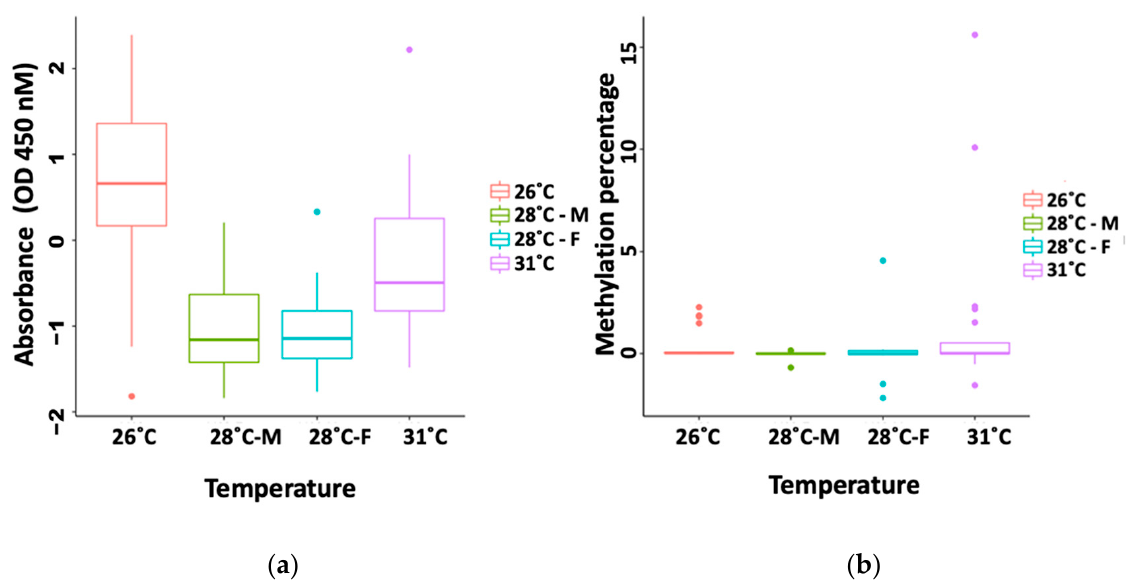
Figure 2. ( a ) Absorbance and ( b ) percent 5-mC DNA methylation values by temperature and sex measured by ELISA in the tail of Chrysemys picta hatchling tail tissue. Table 1. ANOVA results for absorbance and percent 5-mC DNA methylation values measured by ELISA in the tail of Chrysemys picta hatchling tail tissue.